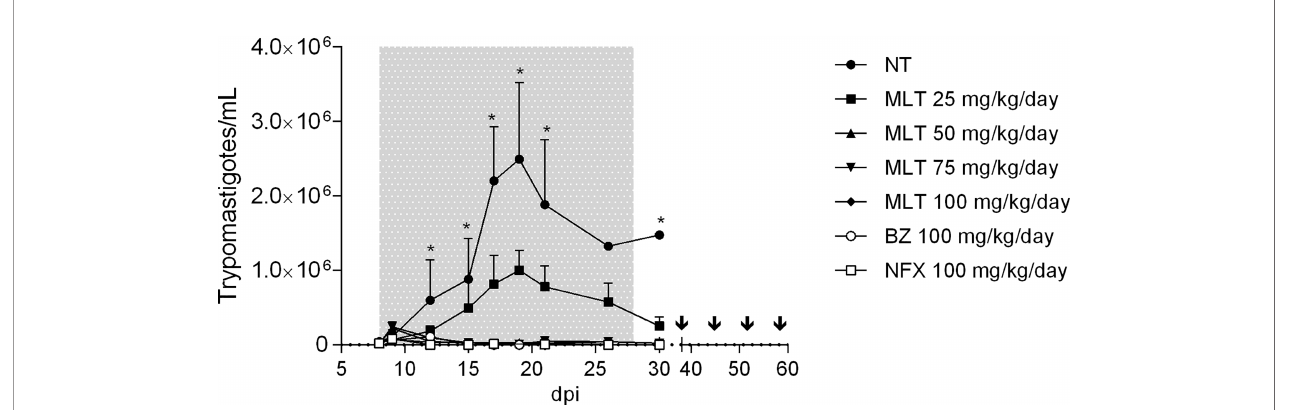
FIGURE 2 | Effect of miltefosine, benznidazole, or nifurtimox on parasitemia course in BALB/cJ mice infected with Trypanosoma cruzi (VD strain). Values are expressed as mean trypomastigotes/mL (± SD) in peripheral blood from experimental groups according to the days after infection (dpi). Mice were inoculated with 500 trypomastigotes of the VD strain of Trypanosoma cruzi , and treatment started at parasitemia onset (8th dpi). During treatment and up to 10 days post-treatment, parasitemia was evaluated by fresh blood examination (FBE) to determine parasitemia rebound. Animals with negative parasitemia were submitted to immunosuppression consisting offour doses of cyclophosphamide (CYP; 200 mg/kg; ip route), separated by one week. Parasitemia was evaluated during the CYP cycle and up to 7 days after the last dose. The asterisks indicate signi fi cant differences compared to NT and MLT 25 mg/kg/day groups (Kruskal-Wallis, p < 0.05). Grey shading indicates the treatment period. Arrows indicate CYP administration cycle. NT, infected non-treated. MLT, miltefosine. BZ, benznidazole. NFX, animals with amastigote nests was signi fi cantly higher in the NT group than in other treatment groups, in skeletal and myocardial muscle (Chi-square, p=0.0003 and 0.0044, respectively). No signi fi cant differences were detected between the groups receiving MLT, BZ, or NFX, both in skeletal muscle and myocardium ( Figure 3 ). Microphotographs of representative skeletal and cardiac muscle samples from different treatment groups can be observed as Supplementary Material ( Figures S3 , S4 , respectively).